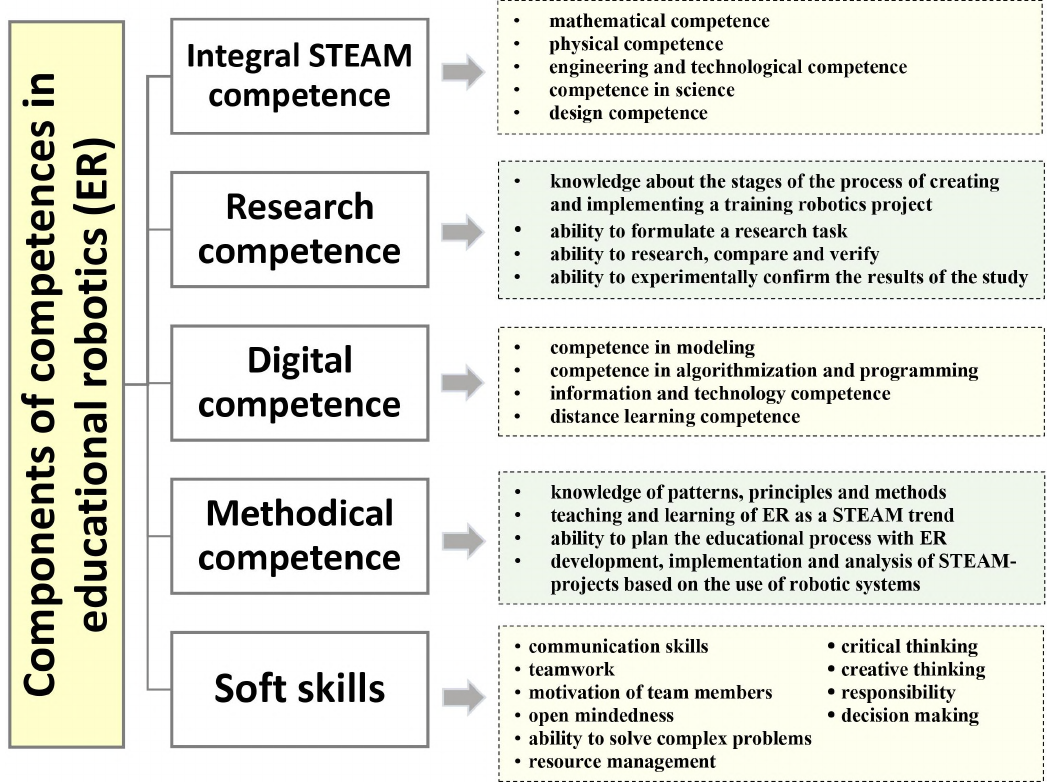
Figure 95: Presentation of paper